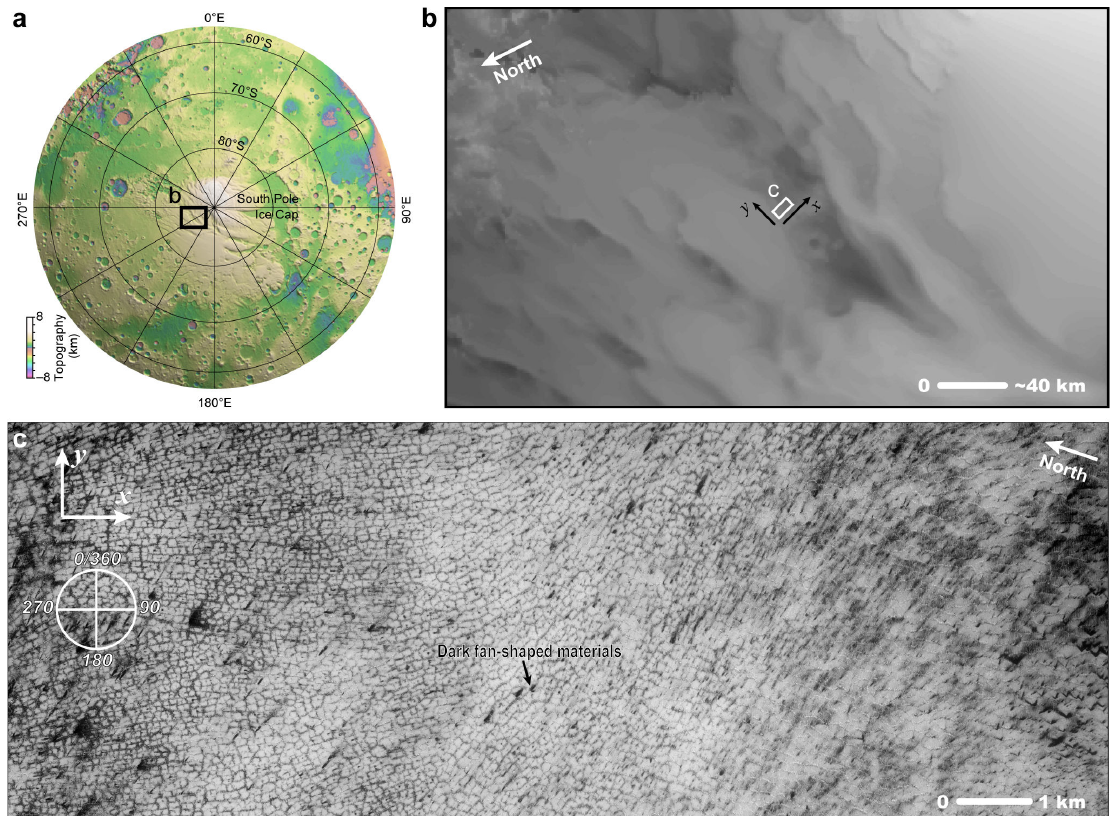
Figure 1. The study region with Martian polygonal terrain on the southern polar cap. ( a ) Martian topographic map centered on the south pole. The topography is exaggerated for better visualization. ( b ) Enlargement view for a region of the ice cap. The white rectangle indicates the region shown in ( c ). ( c ) The image of the polygonal terrain, taken by HiRISE (ID: ESP_039633_0950). Image credit of HiRISE: NASA/JPL/University of Arizona. The elevation data was obtained from The Mars Orbiter Laser Altimeter (MOLA) database (https://attic.gsfc.nasa.gov/mola/ (accessed on 1 September